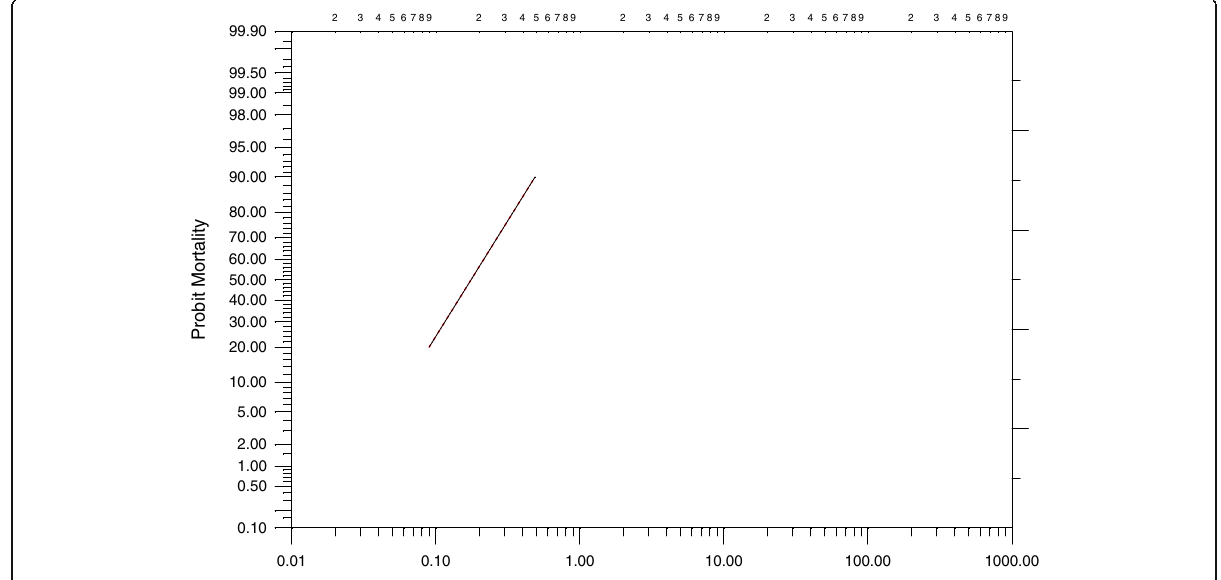
Fig. 1 Log. conc. “ ppm. ” Probit line of Culex pipien s to Bacillus sphaericus